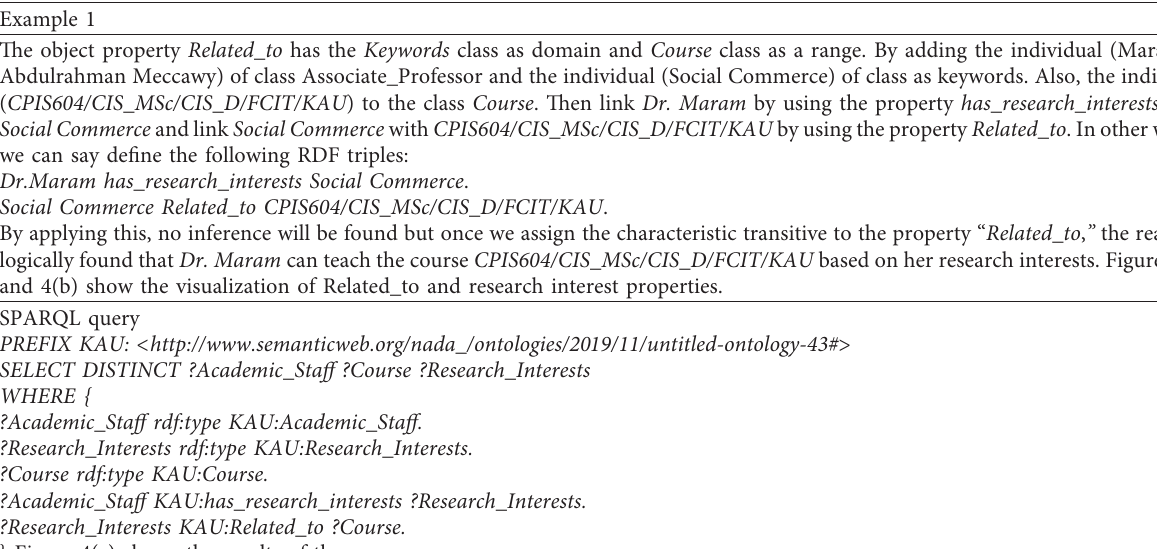
Table 3: The research interests